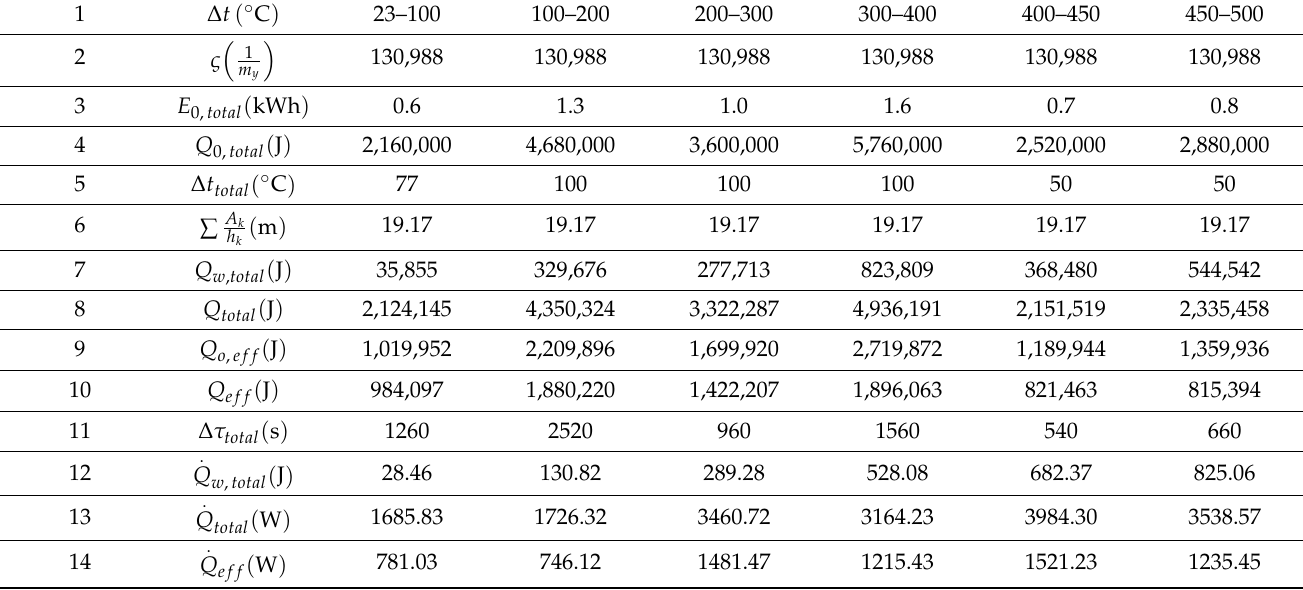
Table A4. Middle model painted—scale 1:2.